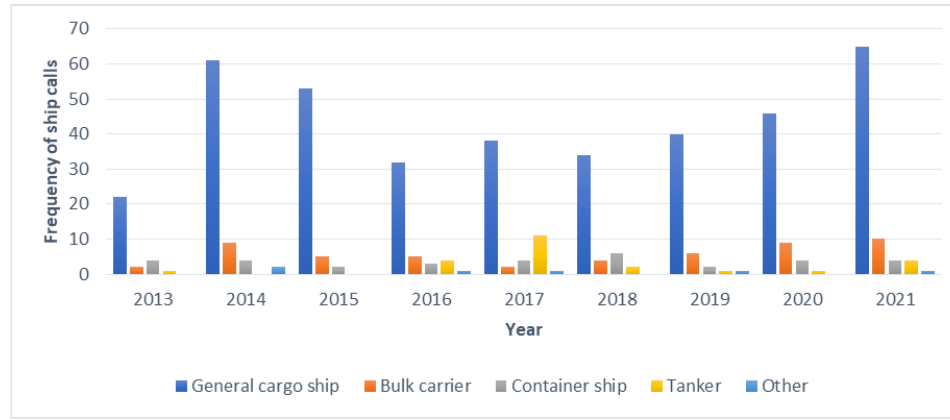
Figure A3. Annual BW quantities discharged by ship type.